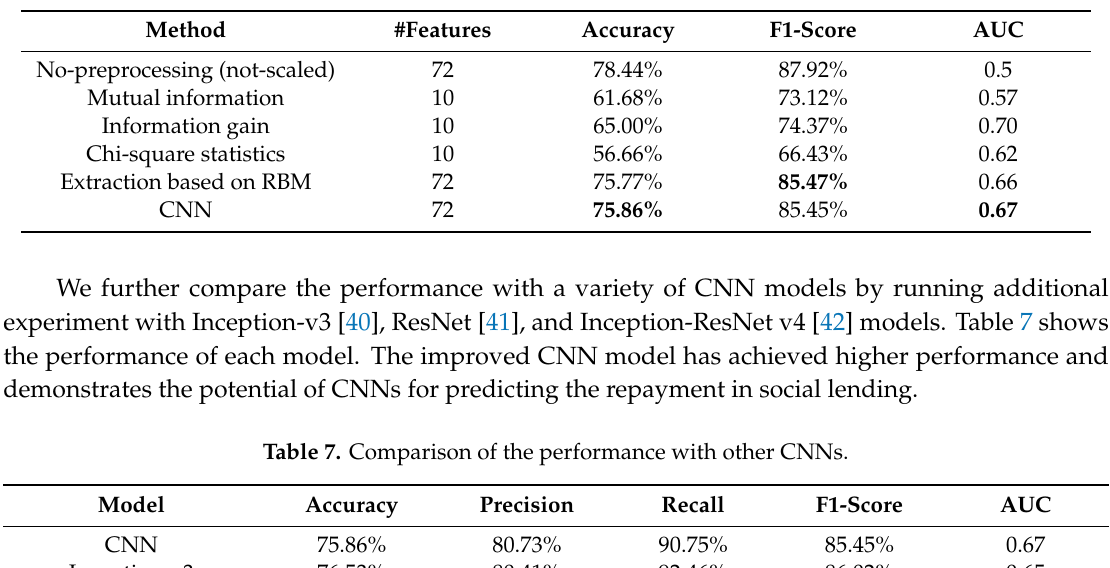
Table 6. Comparison of the performance by preprocessing and feature extraction methods.